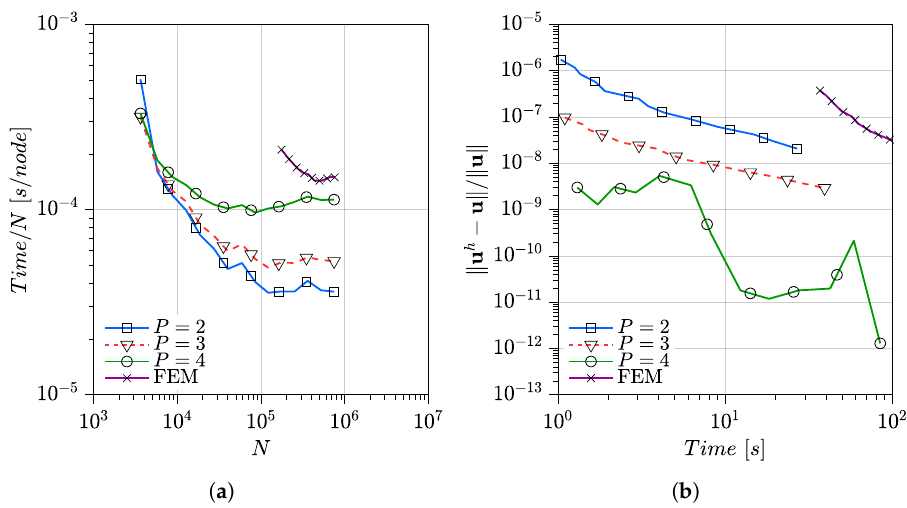
Figure 9. Time per node ( a ) and error vs. time ( b ), Ω : Engine, Dirichlet